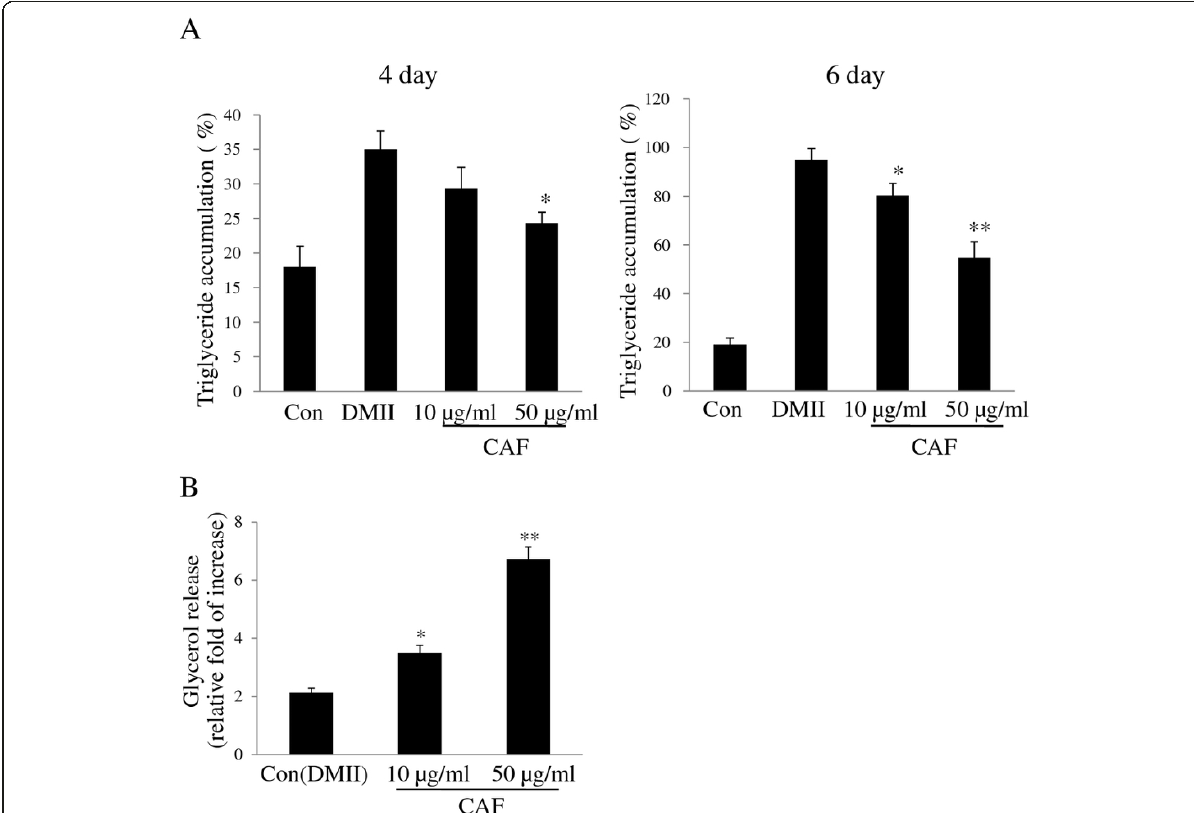
Figure 4 Effect of CAF on triglyceride accumulation and lypolytic activity in 3T3-L1 adipocytes . Confluent 3T3-L1 preadipocytes were differentiated into adipocytes in DMII medium for 6 days. (A) CAF reduced TG content during differentiation of 3T3-L1 cells. 3T3-L1 preadipocytes were differentiated in the absence or presence of CAF for 4 or 6 days, and the lipid accumulation was measured by triglyceride assay. Data are mean ± SD values of at least three independent experiments. (*) p < 0.05, (**) P < 0.01 compared with the differentiated adipocytes (control). (B) CAF increased lipolytic activity in 3T3-L1 adipocytes. The lypolytic activity of CAF was determined by measuring glycerol levels secreted in medium. All experiments were performed on triplicates for each treatment. Values represent mean ± SD. (*) p < 0.05, (**) P < 0.01 compared with the untreated adipocytes